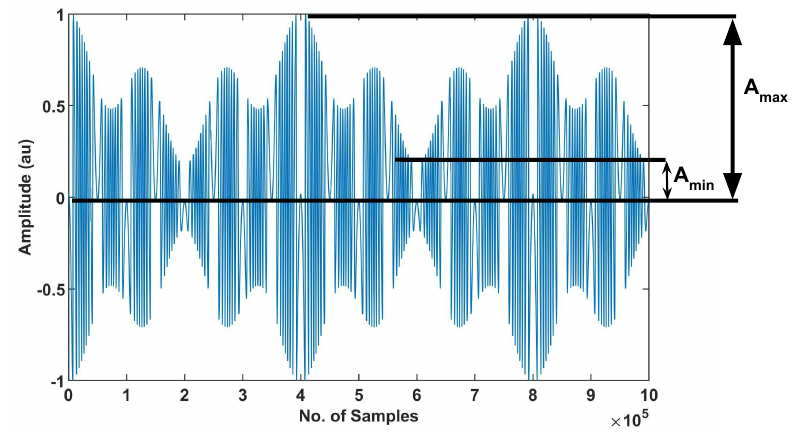
Figure 16. A max and A min are shown for a simulated VOF-based SMI signal.